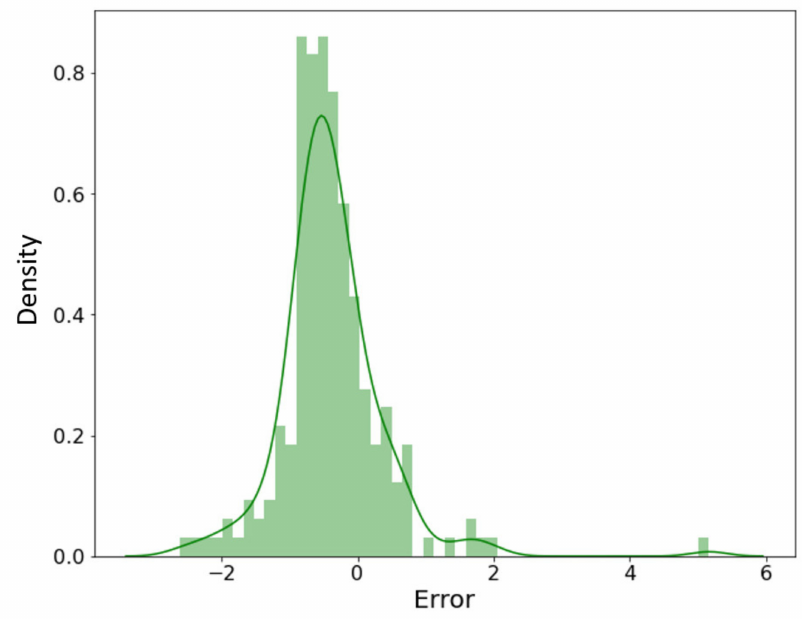
Figure 8. Error density